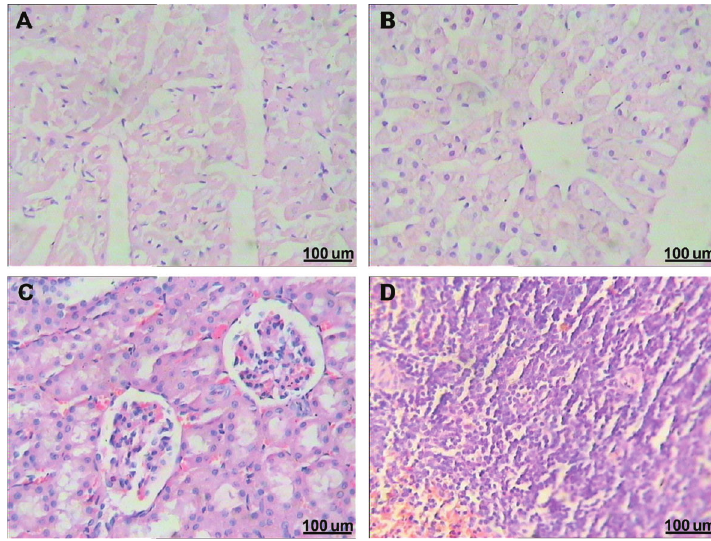
Figure 4. Hematoxylin-eosin staining of the heart ( A ), liver ( B ), kidney ( C ), and spleen ( D ) of the rabbit with magnesium scaffold 3 months after implantation showed no pathological changes (40 6